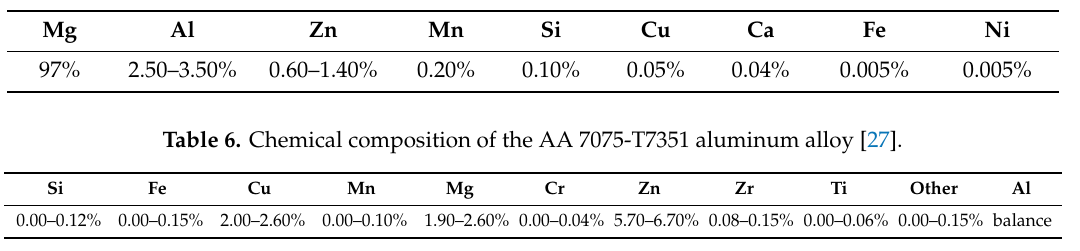
Table 5. Chemical composition of the AZ31B magnesium alloy [26].